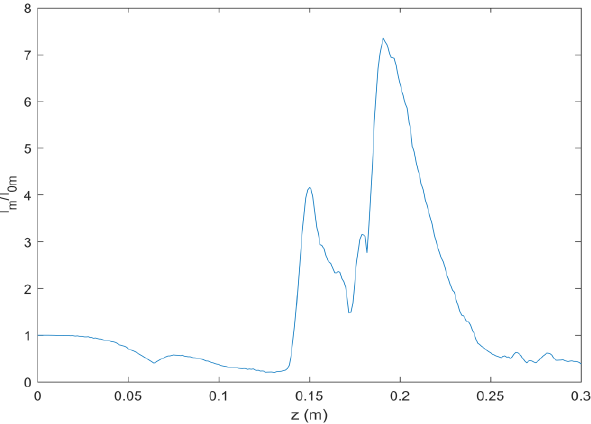
Figure 2. The propagation dynamics of the LHCP component.